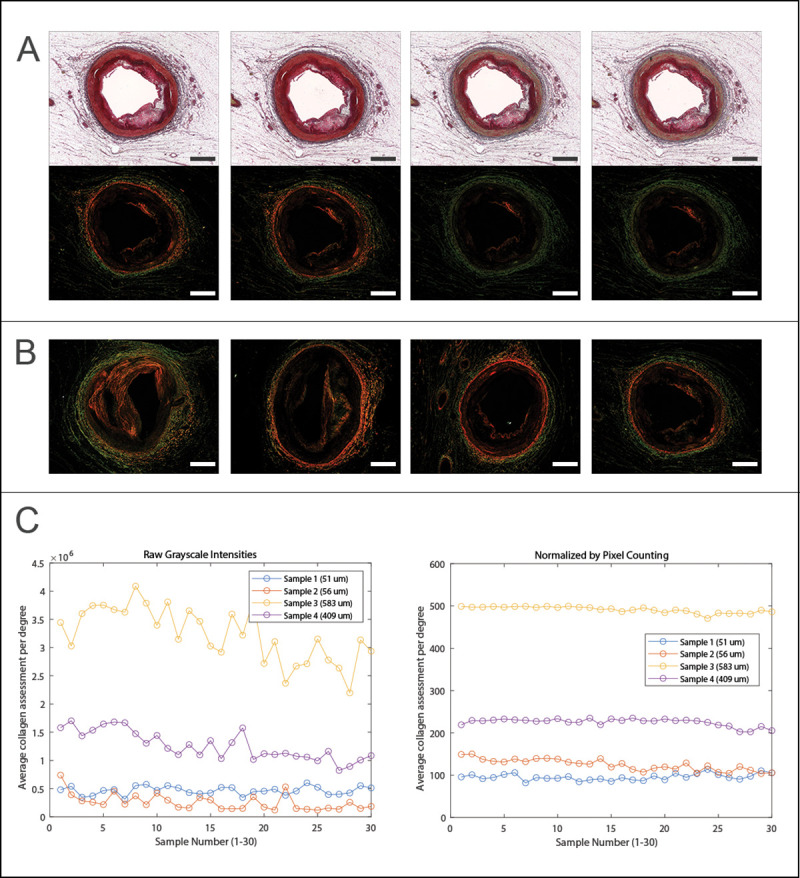
Repeatability.(A) Four example serial sections (each cut at 7 μm thick) from the same 2 mm tissue block, and changes to both bright light (top) and polarized light (bottom) images are observed in the cap region. (B) Four different sections (numbered from left to right) from 3 different hearts showed increased repeatability in (C) with pixel counting method compared to use of grayscale intensity. Scale bars = 1 mm.